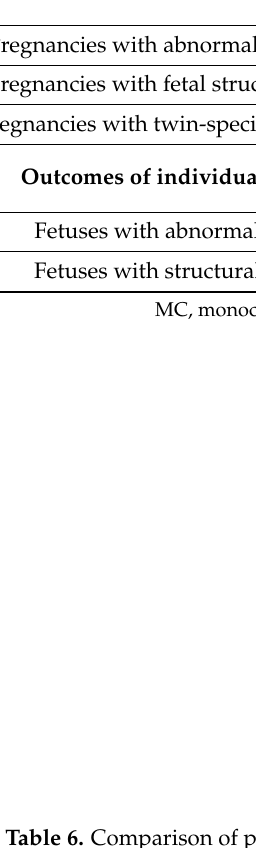
Table 6. Comparison of pregnancy outcomes between DC and MC in pregnancies and individual fetuses with INT ≥ 95 th . Outcomes in Pregnancies with